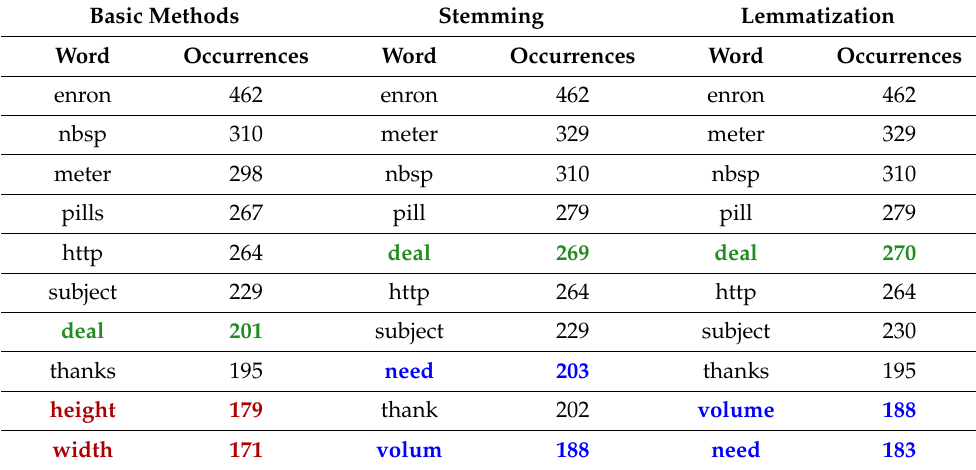
Table 8. Ten most common features for dataset